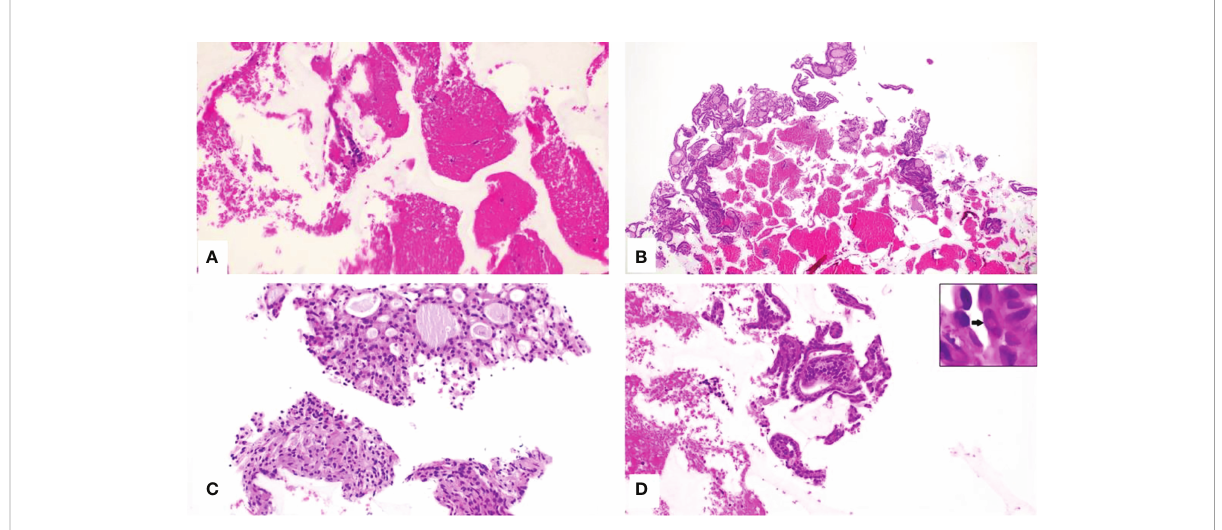
FIGURE 3 (A – D) , CytoFoam Core Quality Classi fi cation. Hematoxilin & Eosin staining of the CFCS Histology, (H&E)x200: (A) Non-diagnostic sample due to the insuf fi cient number of cells (Class I); (B) Sample from a benign thyroid nodule showing an adequate number of colloid containing follicles (Class II); (C) Indeterminate sample showing an adequate number of thyrocytes, mainly organized in microfollicular structures and with minor cellular atypia (Class III); (D) Tissue fragment with groups of irregular cells. The nuclei are variably enlarged with intranuclear inclusions (arrow inset) (Class